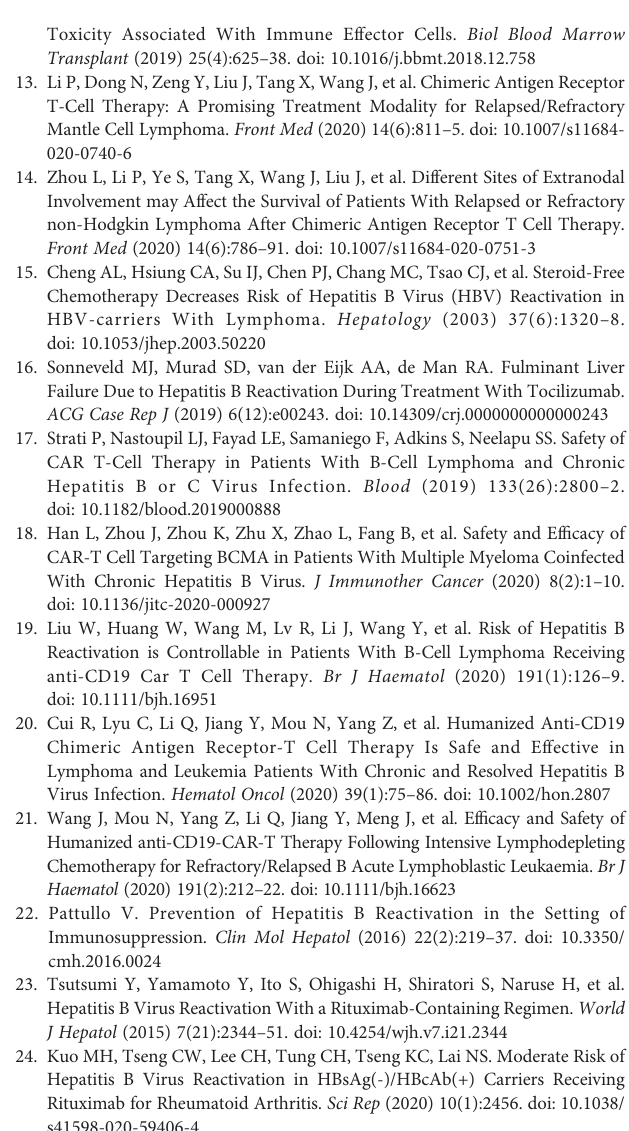
Supplementary Figure 1 | Dynamic changes of CAR copies/ug DNA, percentage of CD19+ B cells in PBMC and serum levels of IgG, IgA and IgM after CAR-T cell infusion in the patients without HBV reactivation. D, day; m, month; PBMC, peripheral blood mononuclear cells; Ig,